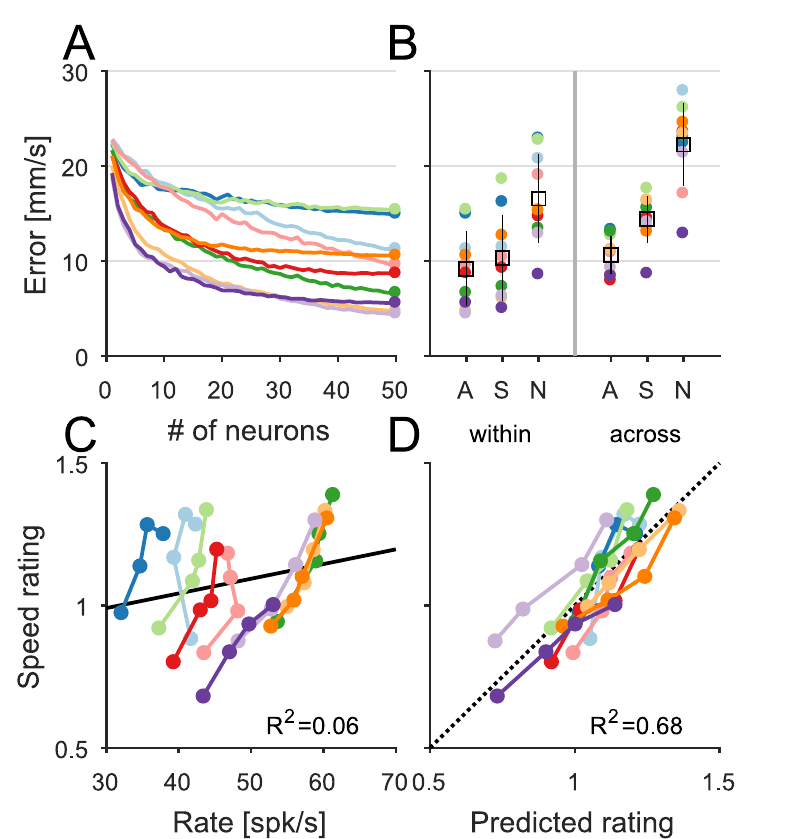
Fig 8. Population coding of speed in somatosensory cortex. (A) Speed decoding performance as a function of number of neurons within texture, including both speed-sensitive and speed-insensitive neurons. Each color denotes a different texture (see legend in Fig 6). (B) Speed decoding performance within (left) and across (right) textures, using A ( n = 49), S ( n = 25), and N ( n = 24). Each colored dot is a different texture; the square and line denote the mean ± SD. (C) Speed ratings versus the mean firing rate of the entire cortical population. Each color denotes a different texture. (D) Speed rating versus the best-fitting linear combination of the mean firing rates of the two subpopulations of neurons (speed sensitive and insensitive). Data underlying this figure can be found in S1 Data. A, the entire population of neurons; N, the speed-insensitive subpopulation; S, the speed-sensitive subpopulation; spk,